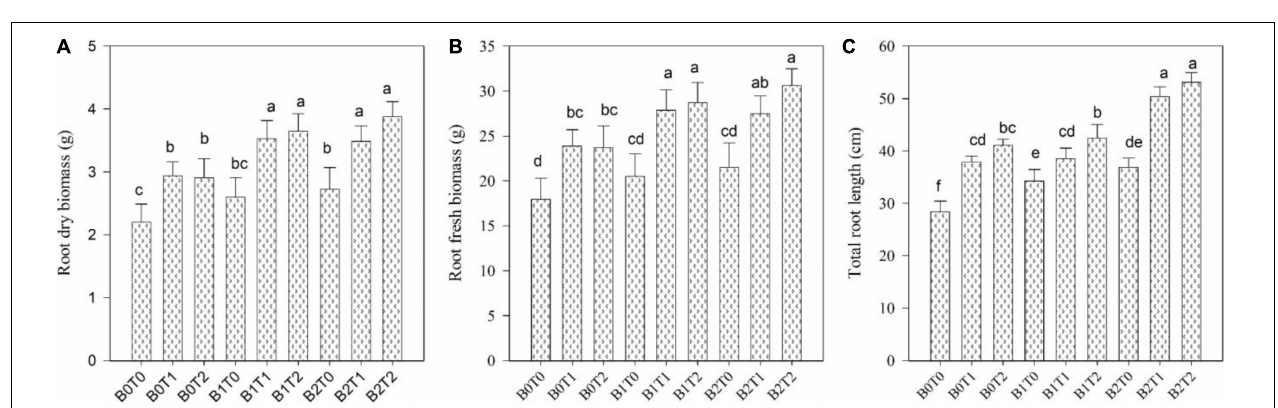
Figure 1 | Effect of combined application of TU and BC on (A) shoot fresh weight, (B) shoot dry weight, (C) leaf area, and (D) shoot length grown under cadmium (Cd) contamination. Values are averages ± SD ( n = 3). Different statistical letters represent significant differences in values between treatments (using Tukey’s multiple range test, p < 0.05). TU, thiourea; BC, biochar; T 0 = 0 mg L − 1 thiourea; T 1 = 600 mg L − 1 thiourea; T 2 = 600 mg L − 1 thiourea; B 0 = 0% w/w BC; B 1 = 2.5% w/w BC; B 2 = 5.0% w/w BC.